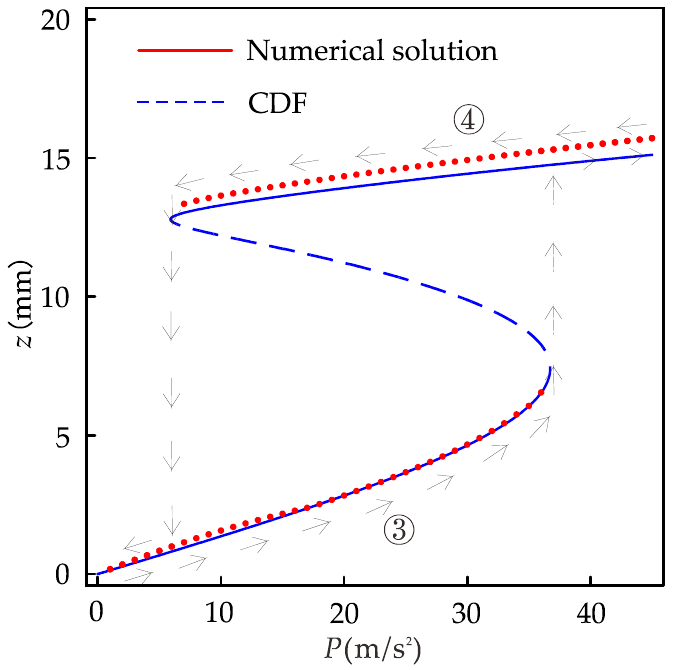
Figure 13. Displacement amplitude versus frequency with f =14 Hz, d =24 mm . Figure 14 shows the relationship between response amplitude and excitation ampli- tude under different excitation frequencies obtained using the CDF method. When the excitation amplitude is in the range of 0 to 10 m/s 2 and the excitation frequency is 4, 10, and 16 Hz, the excitation amplitude range of the system with large vibration is 0.7~10, 3.2~10, and 7.7~10 m/s 2 , respectively; the range of excitation amplitude that can ensure the system vibrates greatly is 1.5~10 m/s 2 , 0, and 0 respectively. High-frequency excitation can obtain a large amplitude response, thus obtaining a higher output power. However, the excitation amplitude range of multi-values is wide, and only small vibration in the multi-values may be obtained, so as to obtain the smaller output. At this time, the low-frequency excitation can obtain a larger response amplitude, but this limits the bandwidth of the system. If the 1/3 subharmonic motion is considered, when the excitation frequencies are 4, 10, and 16 Hz, the excitation amplitude ranges of 1/3 subharmonic motion in the system are 0, 3.2~8.7, and 7.2~32.7 m/s 2 . The excitation amplitude range of 1/3 subharmonic motion is basically in the range of multi-valued excitation amplitude generated by primary reso- nance, and it enlarges with the increase in excitation frequency. Although the amplitude of 1/3 subharmonic resonance is smaller than that of the large amplitude motion of the primary resonance, it is larger than that of the small amplitude of the primary resonance. If 1/3 subharmonic motion is considered instead of the small amplitude motion of the primary resonance, the harvester can obtain more energy. For f = 4 Hz, the system has no 1/3 harmonic resonance, consistent with Figure 12. Combined with the previous analysis, when p > 1.5 m/s 2 , f > 5.5 Hz, 1/3 subharmonic resonance occurs in the system, and when